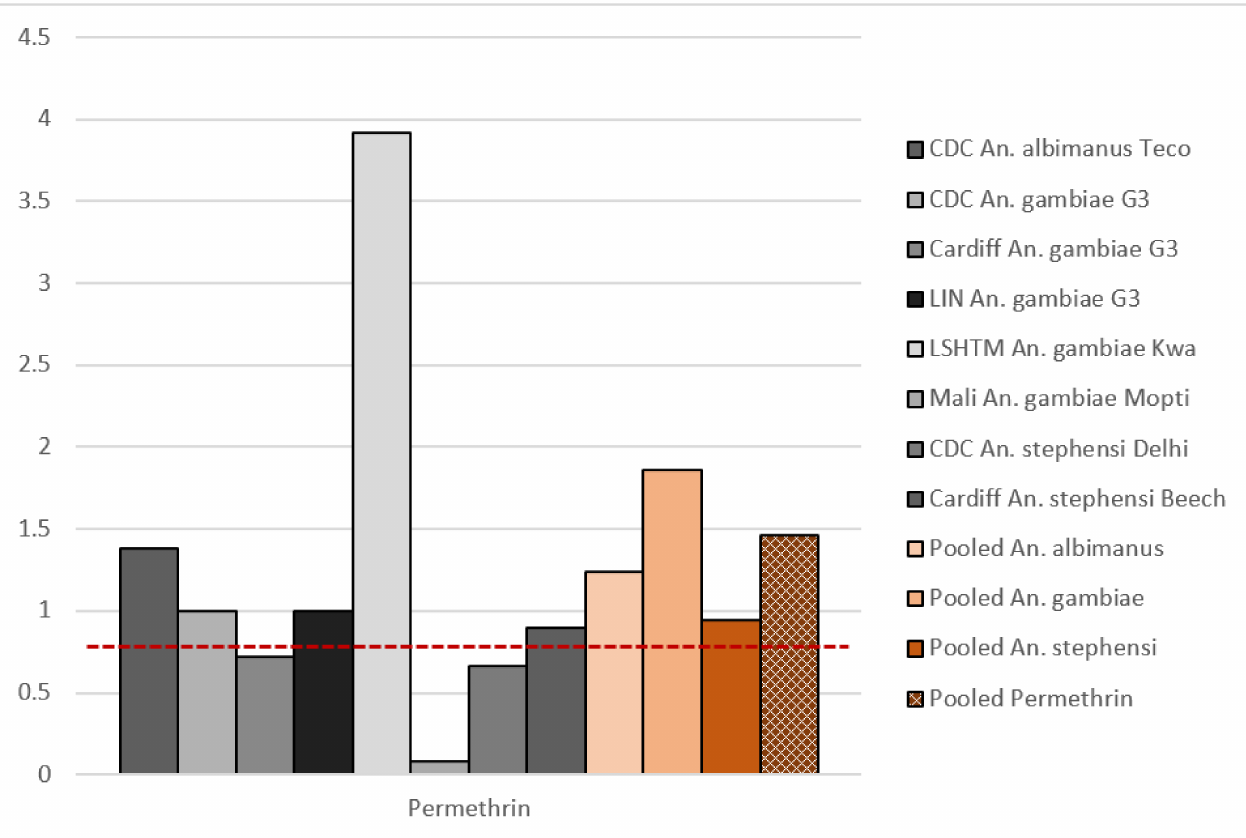
Figure 1. Calculated discriminating doses (%) for deltamethrin ( top ) and permethrin ( bottom ). Points show individual site/strain combinations, and data pooled by species or overall and by the insecticide. Site/strain combinations testing <3 concentrations of an insecticide and datasets that were not robust enough to calculate lethal dose matrixes were excluded. Discriminating doses were set at 2 × the calculated lethal dose at which 99% (LD 99 ) of test mosquitoes were killed. The dashed red line represents the current WHO-recommended DD (0.05% deltamethrin and 0.75% permethrin). LSHTM An. stephensi data are omitted here to improve visualisation of other data points, as their calculated DDs were high. A version with this included can be found in Supplementary Material, Figure S2. Bar charts displaying mosquito mortality (%) following exposure to permethrin and deltamethrin in individual WHO tube bioassays can be found in the Supplementary Material (Figures S3 and S4). Table 1. Probit analysis of 1998 WHO multicentre study. The discriminating dose is 2 × the LD 99